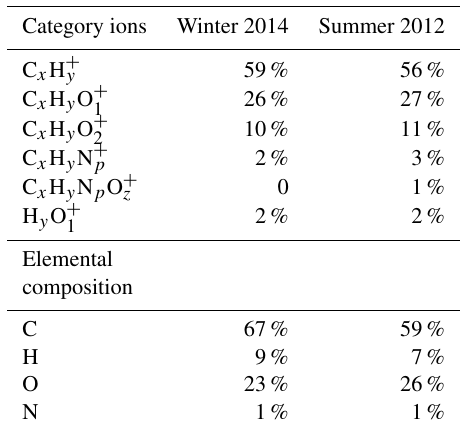
Table 1. Comparison of the composition of category ions and ele- mental composition of OA between winter 2013/2014 and summer 2012. Category ions Winter